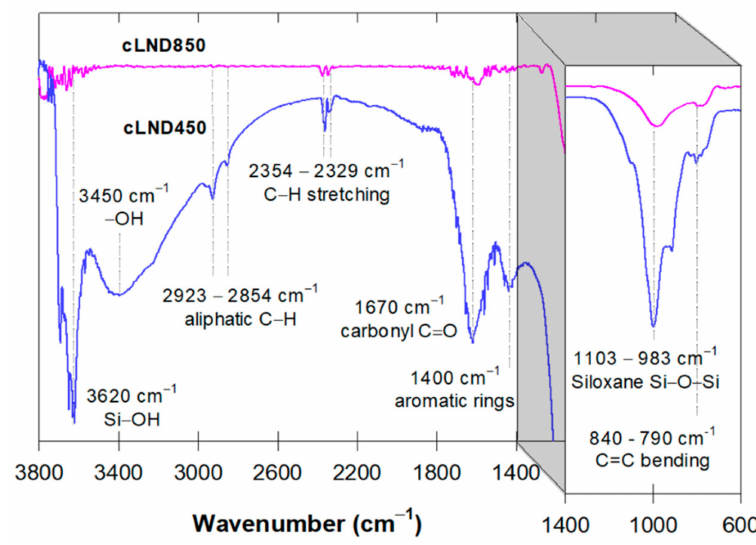
Figure 2. FTIR spectra comparisons between cLND450 and